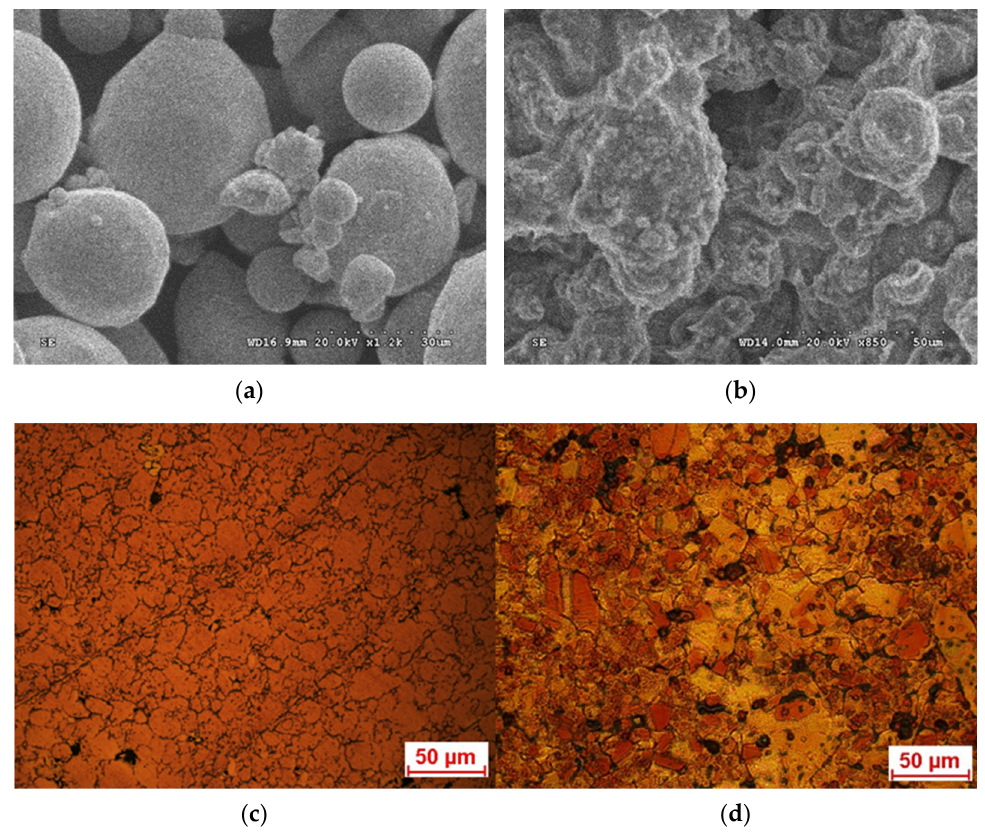
Figure 5. Scanning electron microscope micrograph of the metal matrix, of which the slice was cut